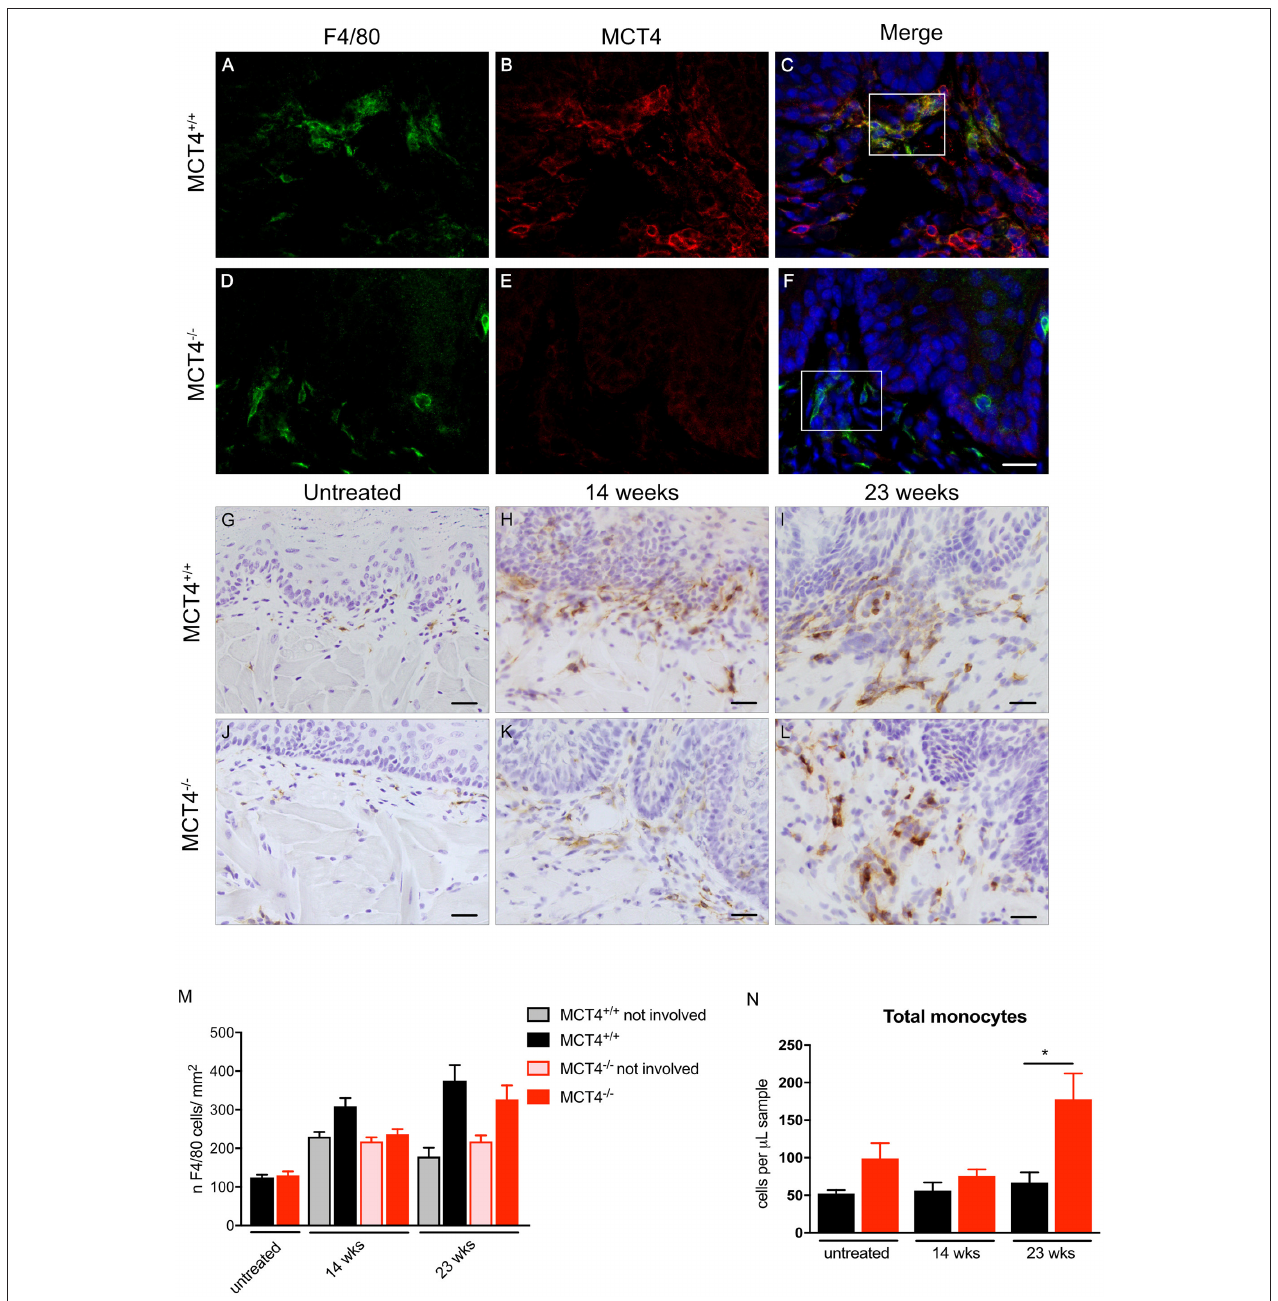
FIGURE 6 | Evaluation of peri-lesional macrophages in wild type and MCT4 − / − tumors. Immunofluorescence staining for F4/80 (green) and MCT4 (red) and dapi nuclear staining (blue) in wild type and MCT4 − / − tongue frozen sections at 23 weeks of 4NQO treatment (A–F) scale bar: 20 µ m. F4/80 staining of frozen sections in untreated tongues and at 14 and 23 weeks 4NQO treatment in wild type and MCT4 − / − animals (G–L) Scale bar: 20 µ m. Quantification of F4/80 positive macrophages in tongue sections. Involved areas represent regions identified by nuclear atypia and/or other signs of epithelial transformation, whereas non-involved areas did not display these features within the same section ( n = 3 for untreated, n = 8 for 14 weeks, n = 4 for 23 weeks per group) (M). Quantification of total monocytes (N) in peripheral blood ( n = 5–6 per group). *P < 0.05.